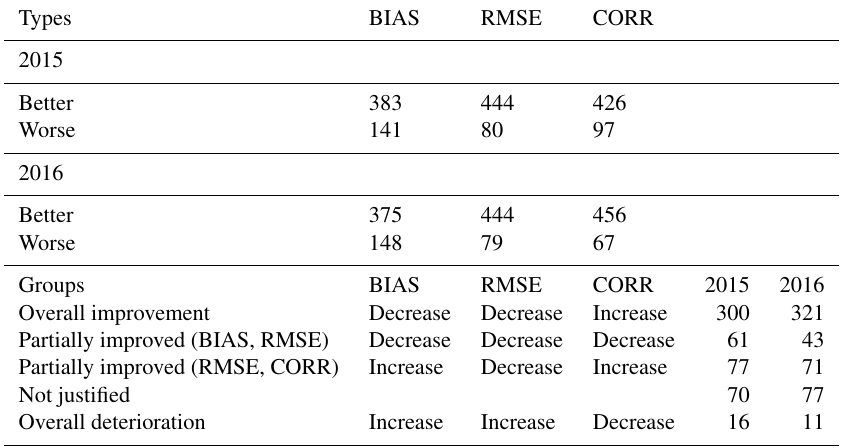
Table 4. Overall statistical changes of the EMIS_DA_FCST experiment compared with the NO_DA_FCST experiment. Types BIAS RMSE CORR